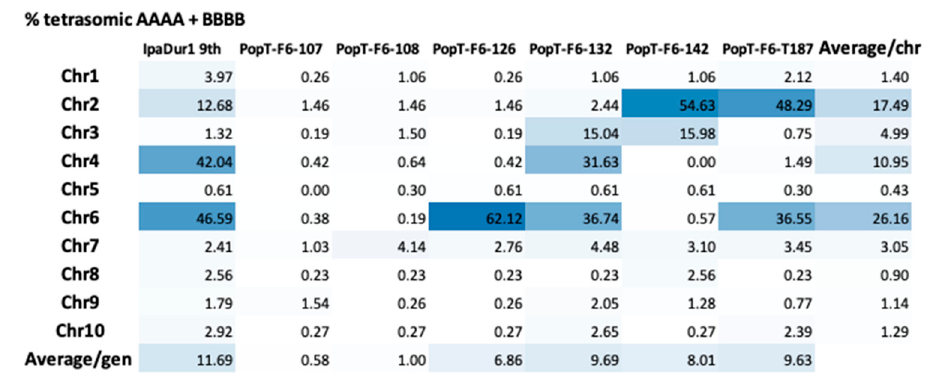
yellow flower color has been introduced into four lines. Line T142 that has no wild introgression in this region has orange flowers (Supplementary File S3 Tab “ A. duranensis ”, and Table 4).